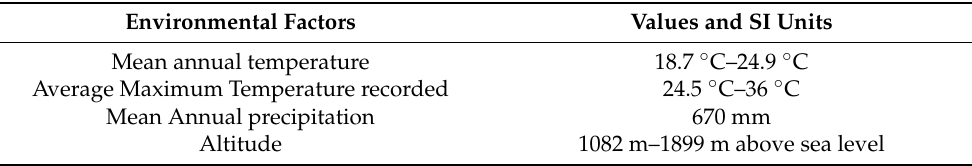
Table 1. Environmental conditions of the study